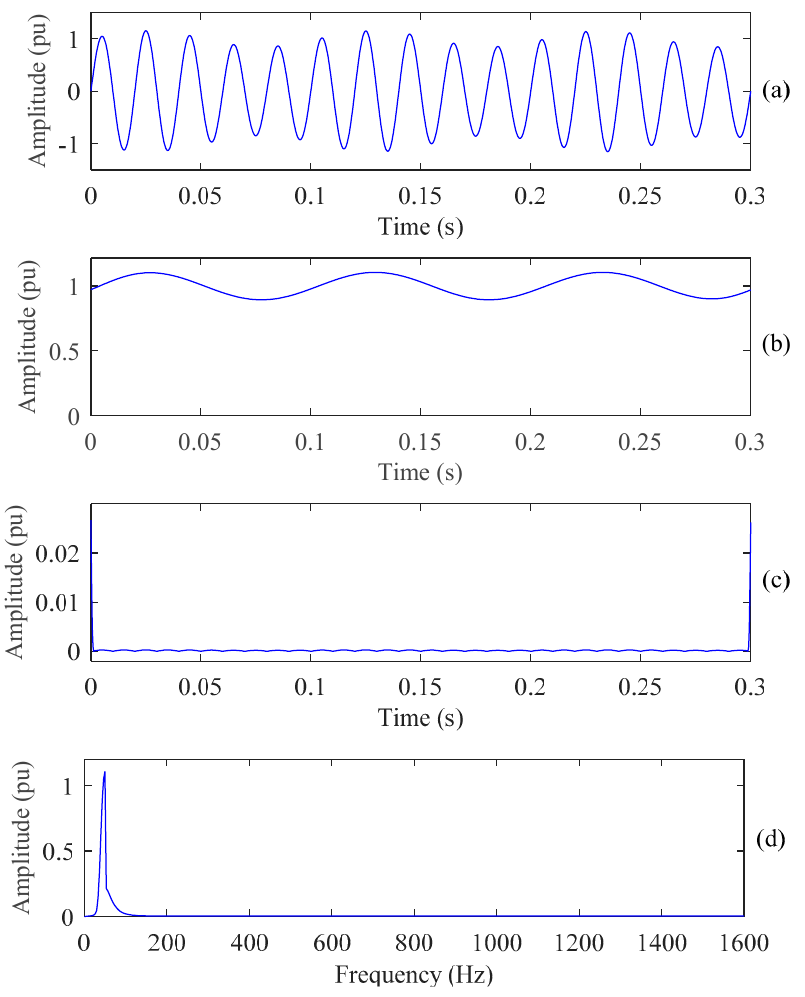
Figure 7. Oscillatory transient and related STA : ( a ) Voltage transient; ( b ) TvA ; ( c ) TvHFA ; ( d ) FvA. Case 7: The sixth disturbance is chosen to be the flicker; in this case, the flicker and related STA plots are illustrated in Figure 8. The presence of flicker be observed by a series of circles in TvA and that is the basic to be utilized to detect the flicker voltage signal.